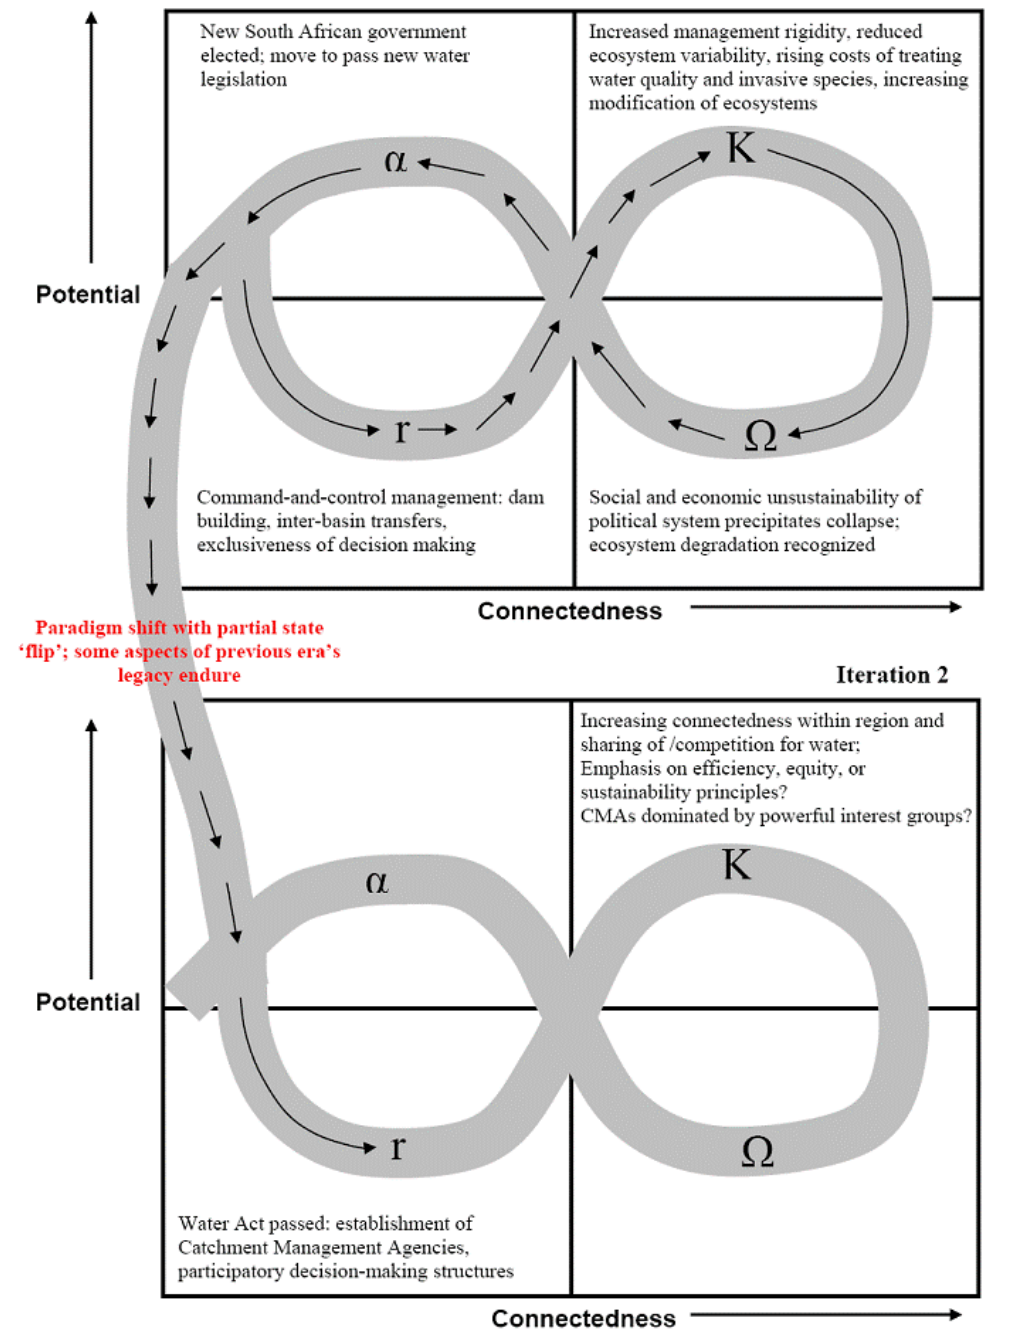
Fig. 2. Adaptation of the adaptive cycle (Holling and Gunderson 2002) to depict two eras of South African water